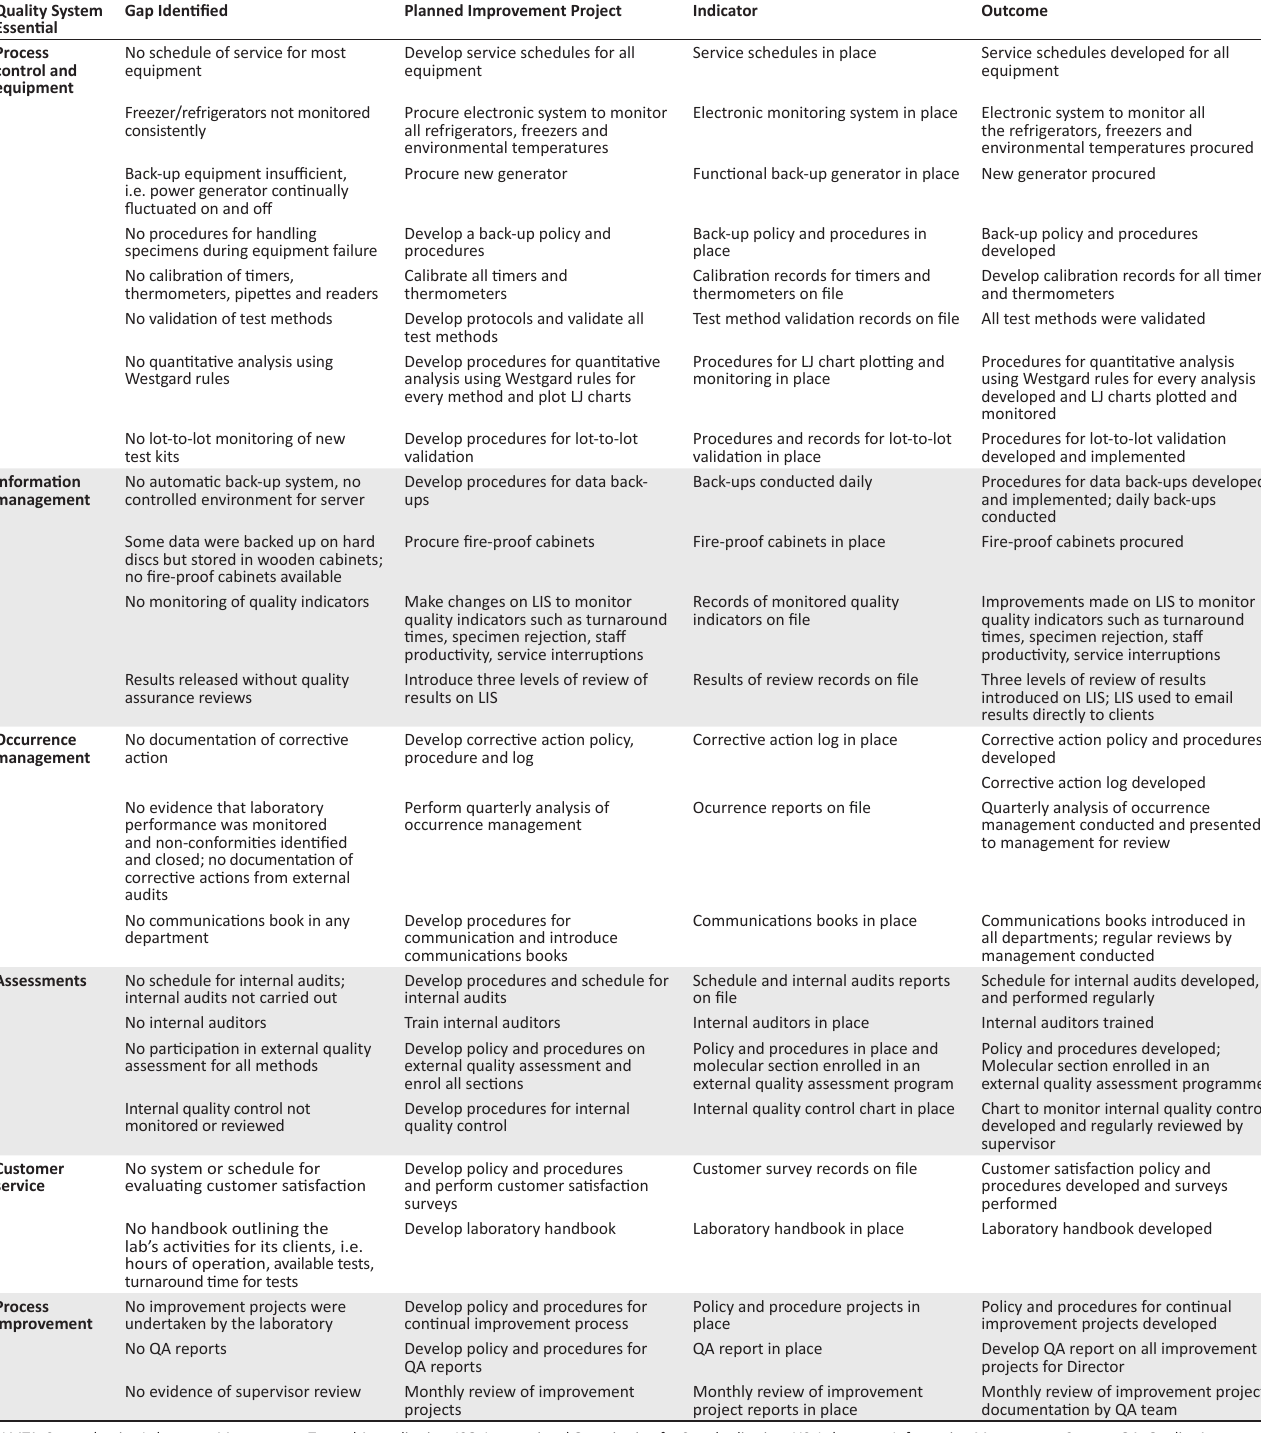
TABLE 1 (Continues...): Gaps identified and corresponding improvement projects conducted for SLMTA implementation at Kenya’s National HIV Reference Laboratory,